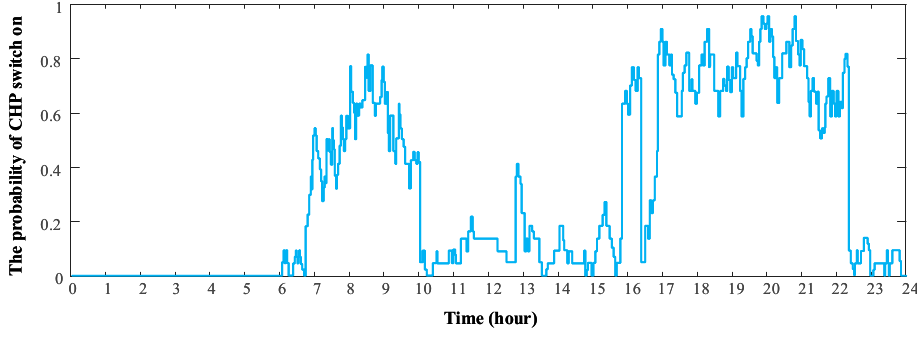
Figure 10. The probability of CHP Switch ‘ON’. Appl. Sci. 2018 , 8 , 0008